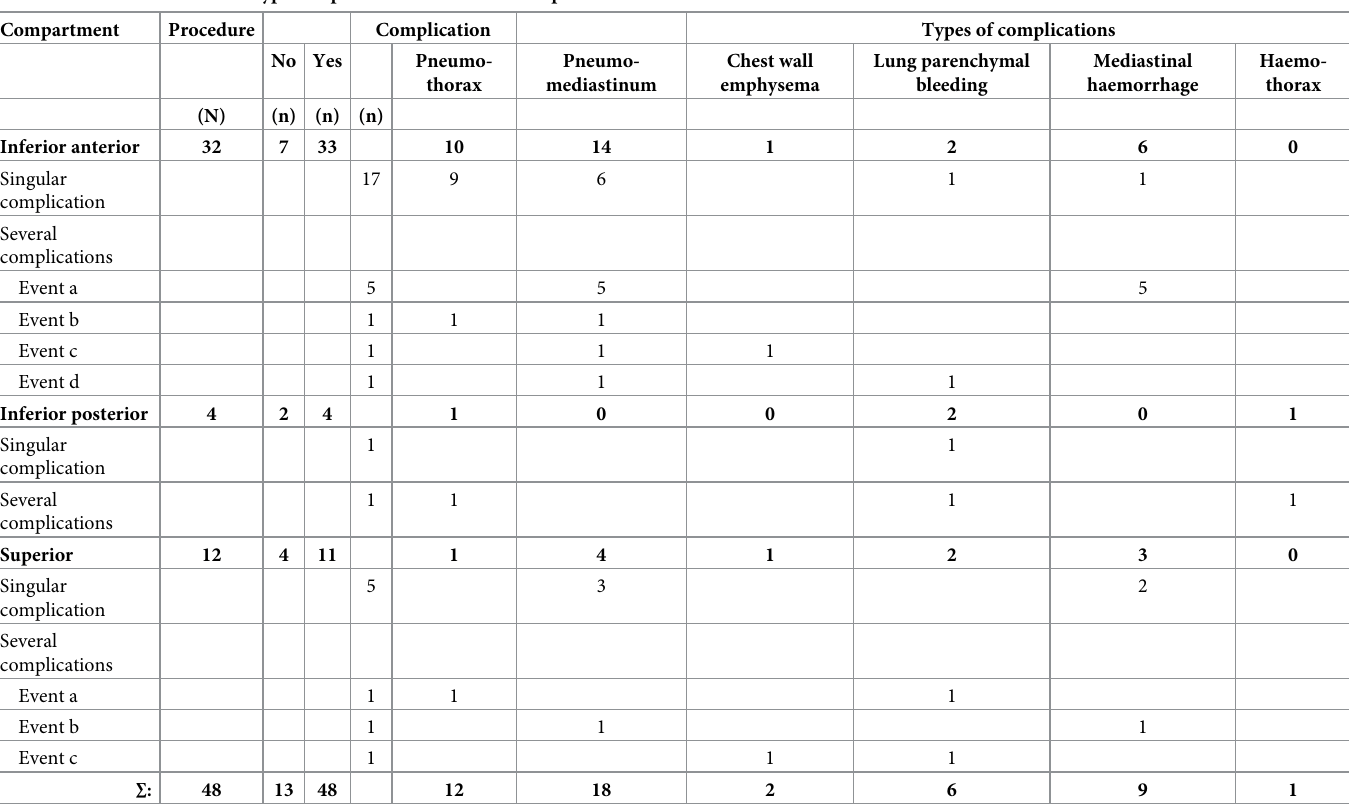
Table 2. Presents number and type complications within each